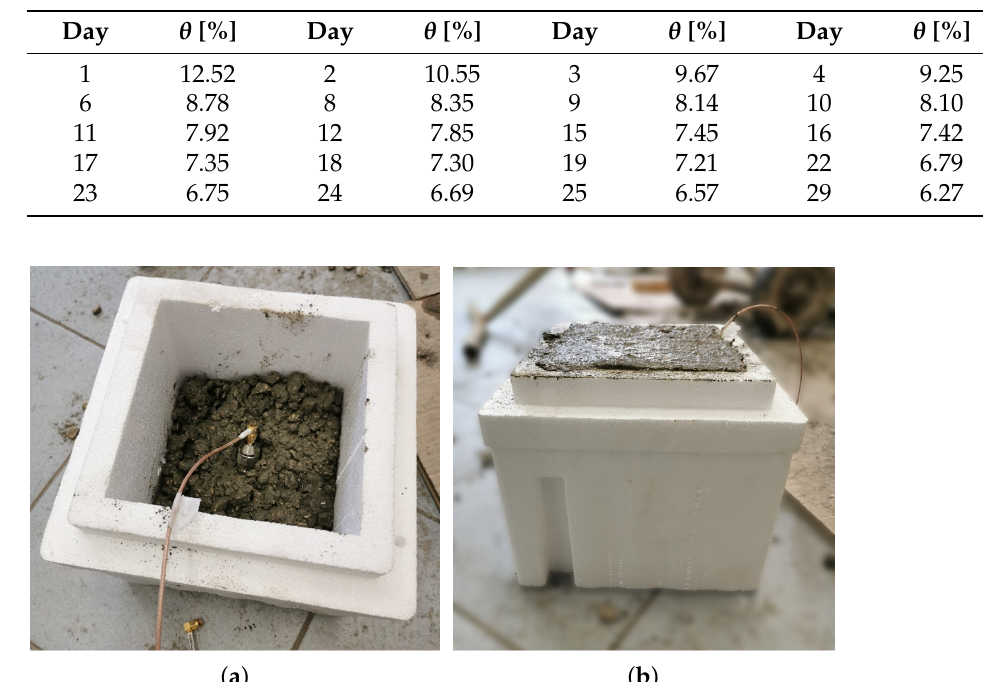
Figure 5. Picture of the preparation of the reference concrete specimen. The PCP is inserted in the fresh mixture.